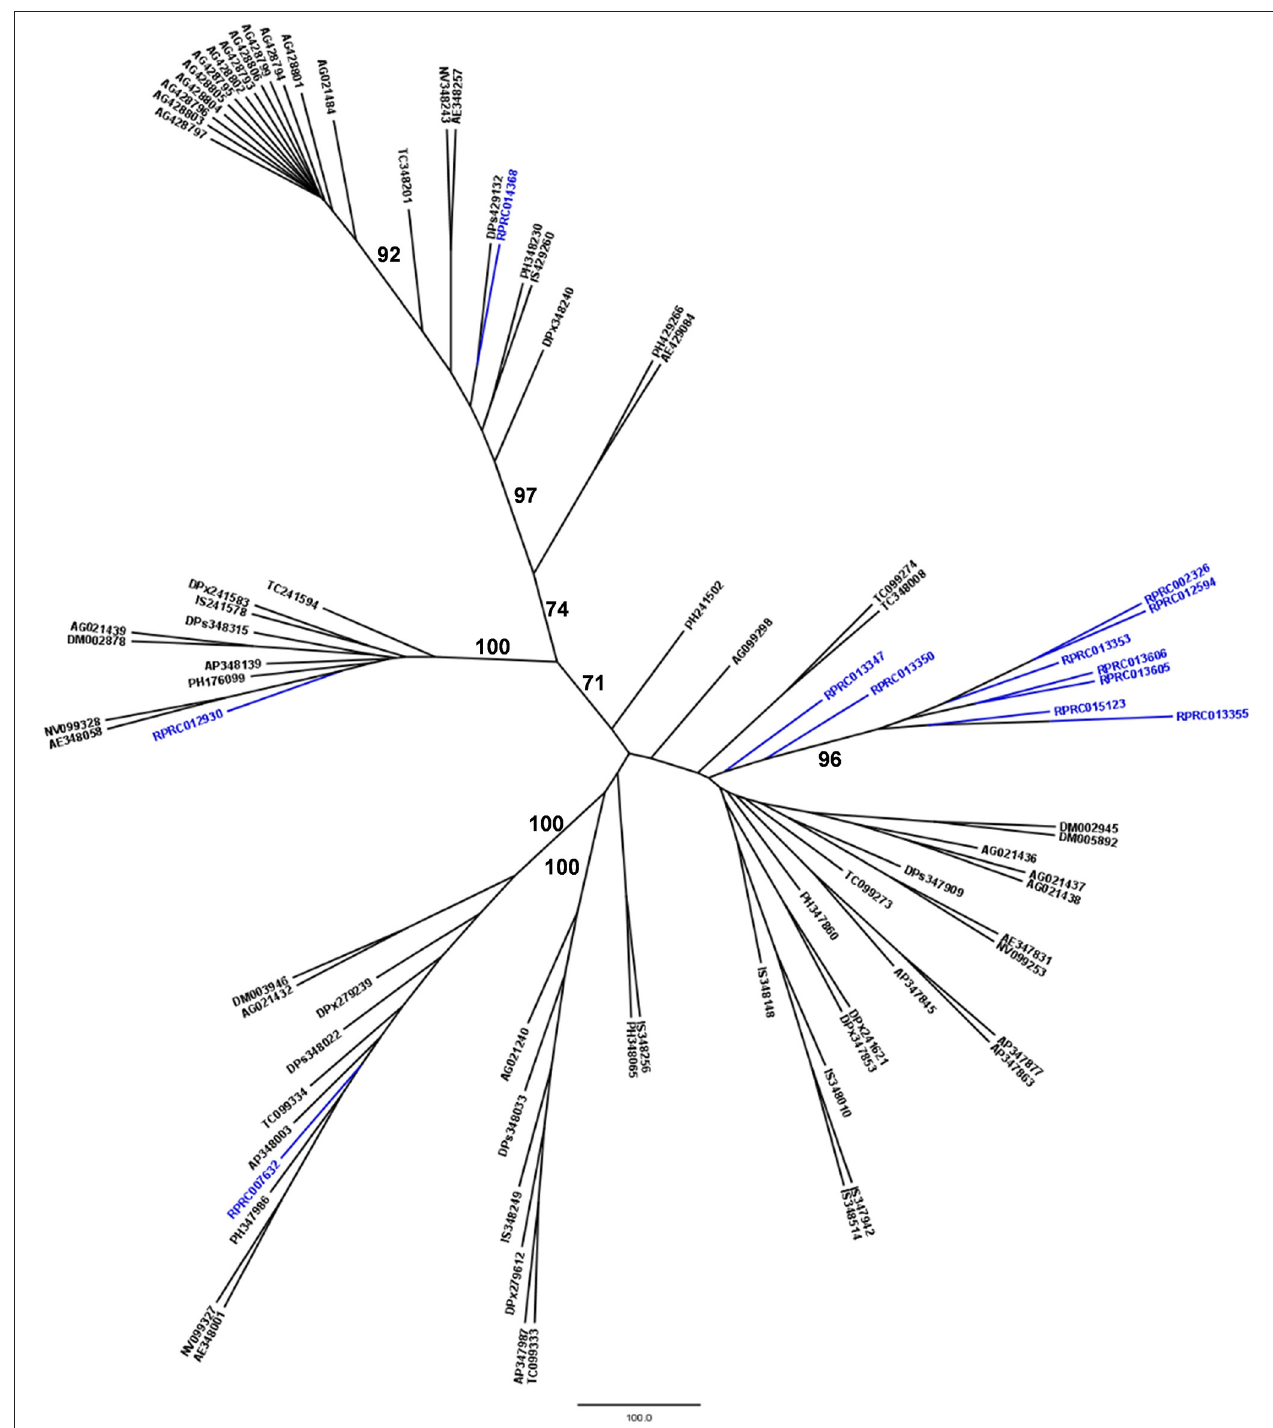
FIGURE 5 | Phylogenetic tree of amino acid sequences from peptidase family C2 (Calpains) common in insect genomes which contain high gene copy numbers in the R. prolixus genome. Tree gather sequences from 19 arthropod species. Blue, branches with Rhodnius prolixus peptidases; Black, branches with peptidases from 18 arthropod species; ACY, Acyrthosiphon pisum ; IXO, Ixodes scapularis ; DAP, Daphnia pulex ; TRI, Tribolium castaneum ; AED, Aedes aegypti ; ANO, Anopheles gambiae ; CUL, Culex quinquefasciatus ; DRm, Drosophila melanogaster ; DRp, Drosophila pseudoobscura ; GLO, Glossina morsitans ; API, Apis mellifera ; ACR, Acromyrmex echinatior ; CAM, Camponotus floridanus ; HAR, Harpegnathos saltator ; SOL, Solenopsis invicta ; NAS, Nasonia vitripennis ; DAN, Danaus plexippus; PED, Pediculus humanus. See Material and Methods for details.